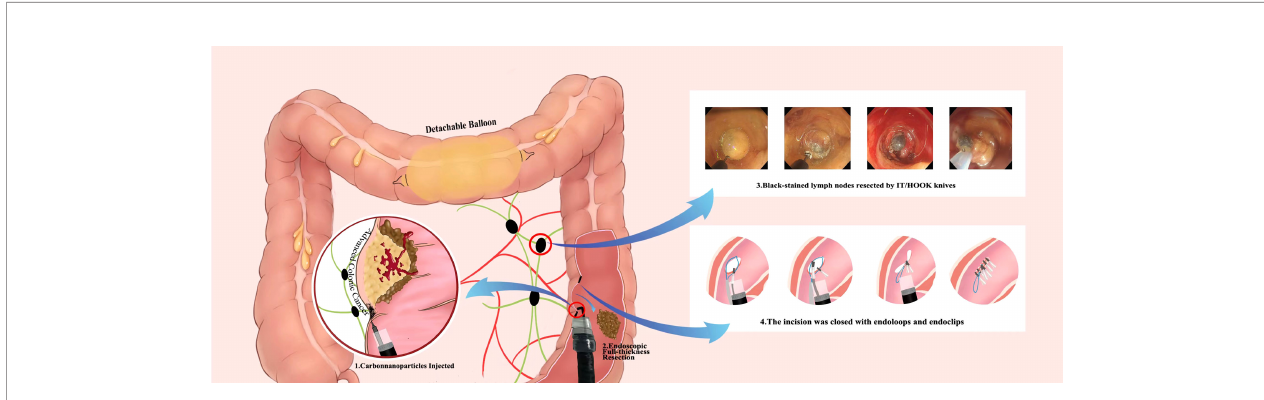
FIGURE 1 | Infographics of endoscopic full-thickness resection and lymphadenectomy for advanced colonic cancer as described by Liu et